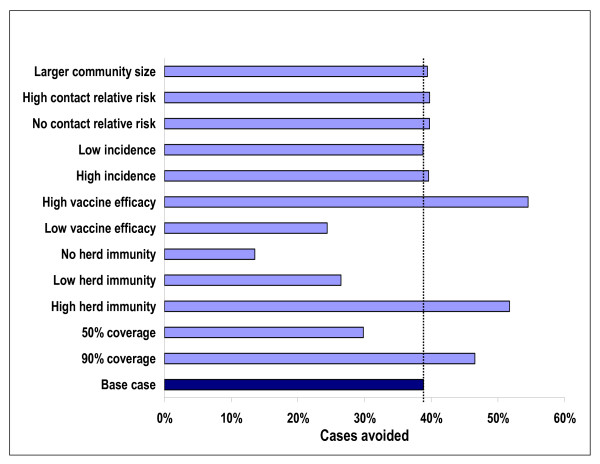
Cases avoided per year with routine vaccination of adolescents under different scenarios at steady state. Larger community size – 500,000 individuals. No/high contact relative risk – 0%/200% of base case relative risk. Low/high incidence – 75%/125% of base case incidence. Low/high vaccine efficacy – doubling/cutting in half the rate of decay for vaccine effectiveness. No/Low/High herd immunity – 0%/50%/150% of base case herd immunity. 50%/90% coverage – coverage rate for routine vaccination.